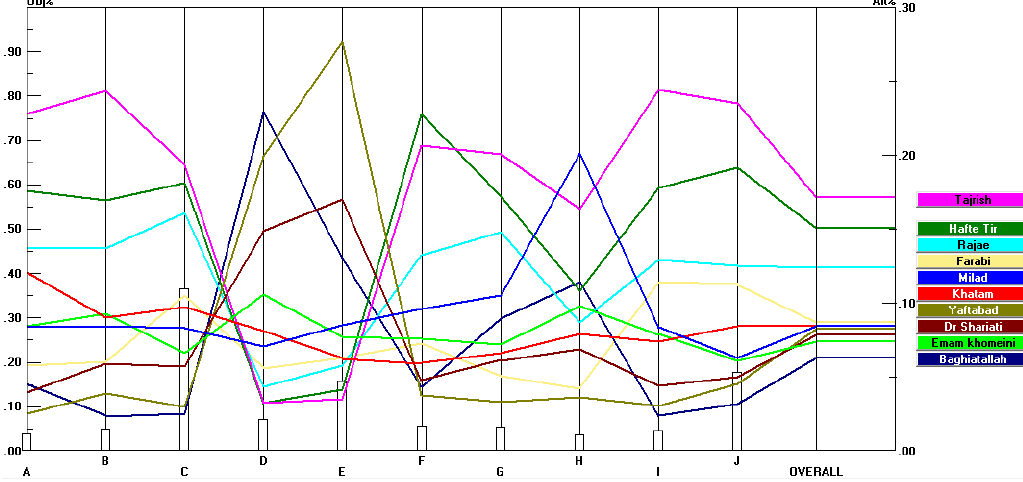
Figure 14. Performance sensitivity